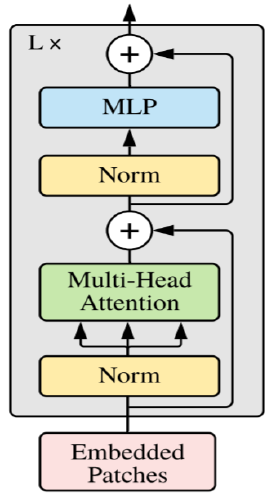
Figure 4. Transformer encoder structure.